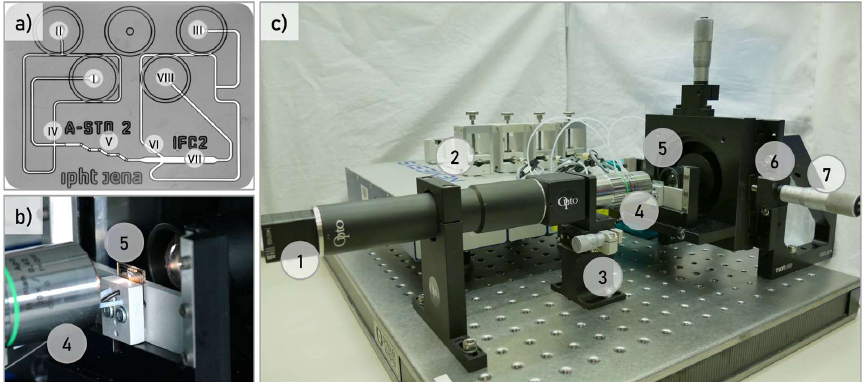
Figure 1. ( a ) Microfluidic chip with (I) Sample inlet, (II) Sheath fluid 1, (III) Sheath fluid 2, (IV) Flow Focusing Unit 1, (V) Flow rotation unit, (VI) Flow focusing unit 2, (VII) MIFC detection channel and (VIII) Waste outlet; ( b ) Chip integration; ( c ) Optical system with (1) Snapshot-mosaic camera, (2) Pressure-pump fluid management system, (3) Z-focus, (4) 20 × Objective, (5) Microfluidic chip, (6) XY-linear stage, (7) LED white light